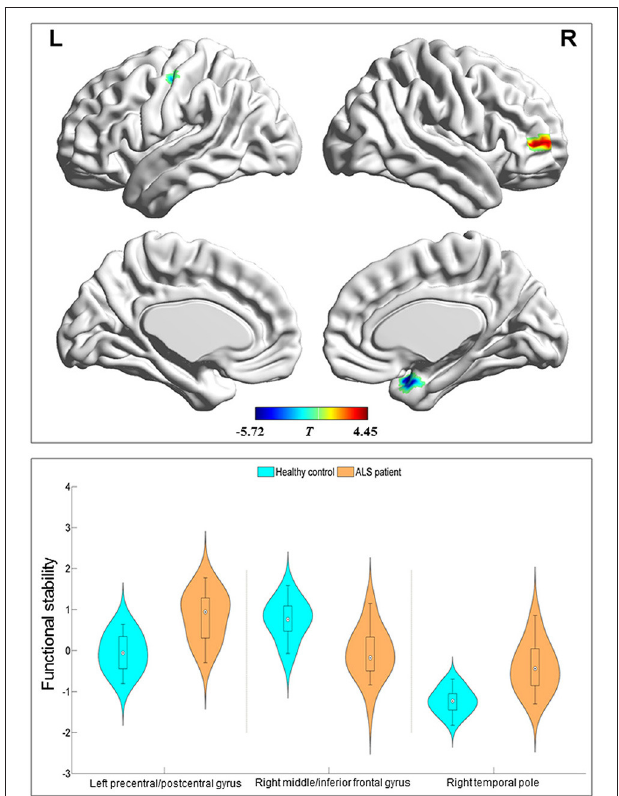
FIGURE 2 | Regions with between-group differences in functional stability. The red and blue color indicate the regions with the decreased and increased functional stability in the patients with amyotrophic lateral sclerosis, respectively. The distribution and between-group differences are shown in the violin and box plots (all P < 0.0001) of mean value of functional stability in these regions. L, left; R,